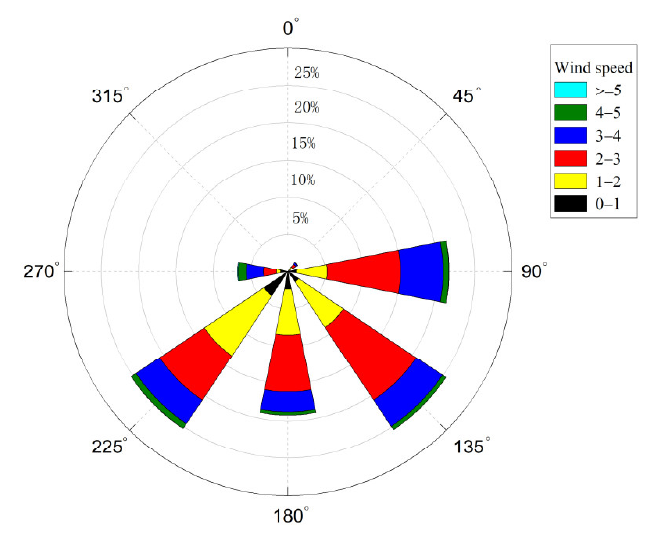
Figure 14. Anemometer E field measurement statistics.